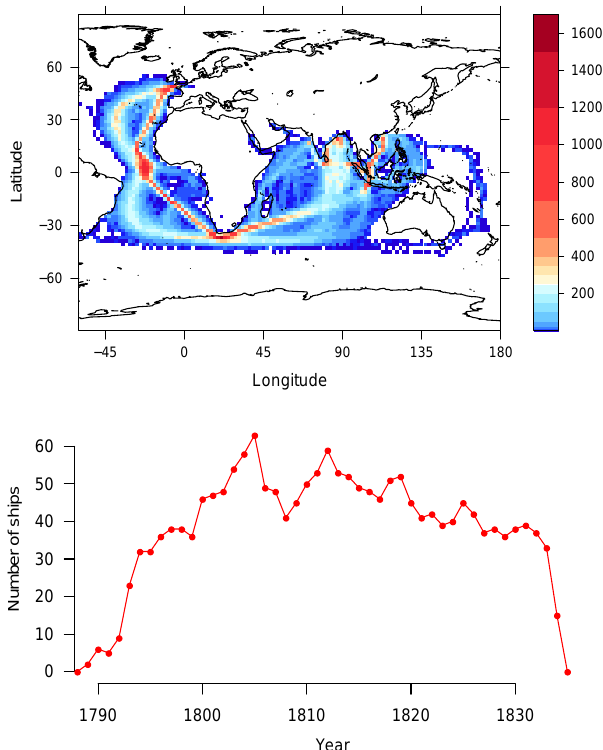
Fig. 4. Geographical coverage of the observations. Upper panel: to- tal number of observations in each 2 × 2 degree square. Lower panel: number of ships providing observations in each year.